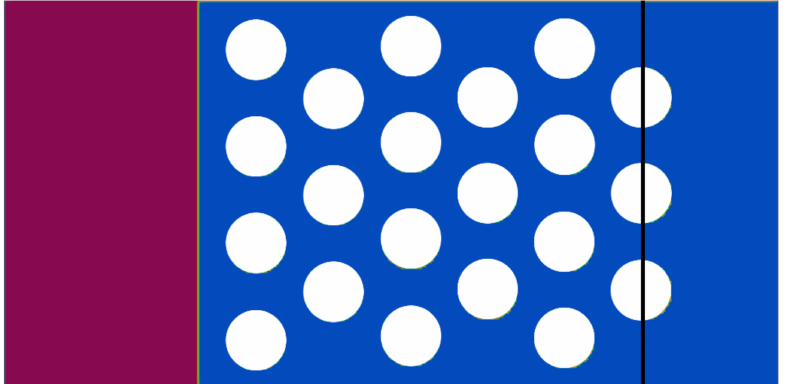
Figure 11. Line probe location (shown in black) in the grid-independence analysis of CO 2 penetration LBM model.